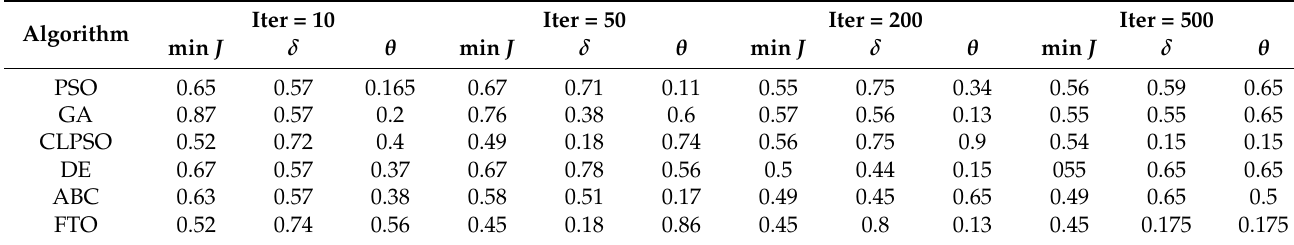
Table 11. The optimization